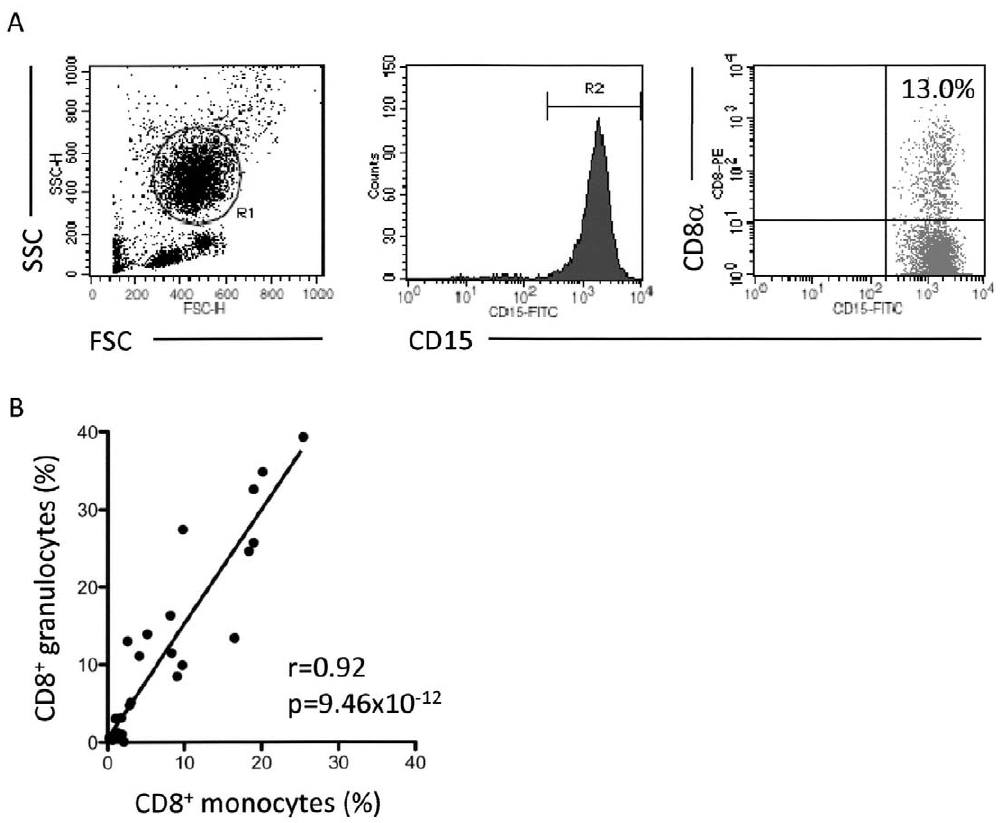
Figure 1. Detection of CD8 + granulocytes and correlation to CD8 + monocytes. ( A ) Detection of CD8 + granulocytes in human peripheral blood samples. Heparinized whole blood samples were made to react with the PE-labeled anti-CD8 a Ab (HIT8a). After depletion of erythrocytes, the cells were re-suspended in PBS, and then allowed to react with the FITC-labeled anti-CD15 Ab (H198). PE-labeled mouse IgG1 and FITC-labeled mouse IgM were used as isotype-matched controls for HIT8a and H198, respectively. The cells gated in R1 were regarded as PMNs. Among the PMNs, granulocytes were characterized by the high level of expression of CD15 (gated in R2). The cells in both R1 and R2 gates were examined for the expression of CD8 a . ( B ) Correlation of CD8 + granulocytes and CD8 + monocytes (n=32, r=0.92, p=9.46 6 10 2 12 in Pearson correlation